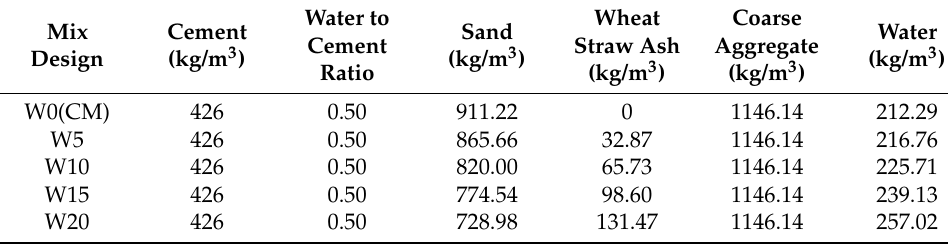
Table 4. Mix proportioning of WSA incorporated